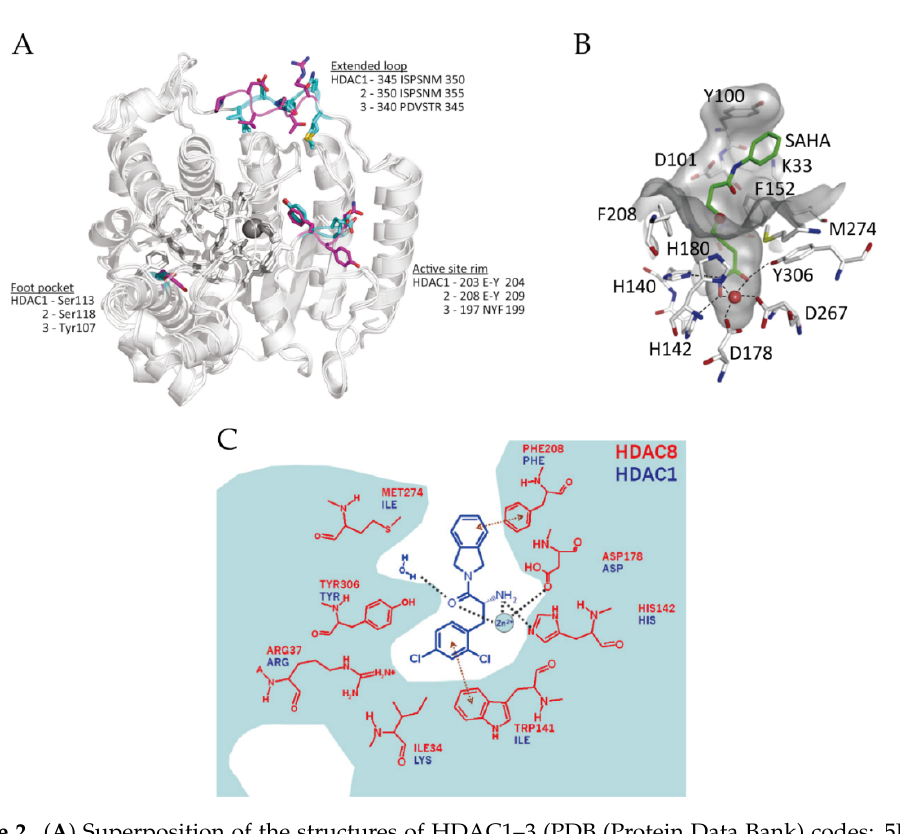
Figure 2. ( A ) Superposition of the structures of HDAC1–3 (PDB (Protein Data Bank) codes: 5ICN, 4LY1 and 4A69). Significant residue di ff erences are highlighted in cyan (HDAC1 and 2) and magenta (HDAC3). Adapted with permission from Millard 2017 [15]. ( B ) The active site of HDAC8 (PDB code: 4QA2). Adapted with permission from Chakrabarti 2015 [17]. ( C ) The foot pocket of HDAC8. Prominent amino-acid side-chain di ff erences between HDAC8 and HDAC1 in the foot pocket are shown. Adapted with permission from Whitehead 2011